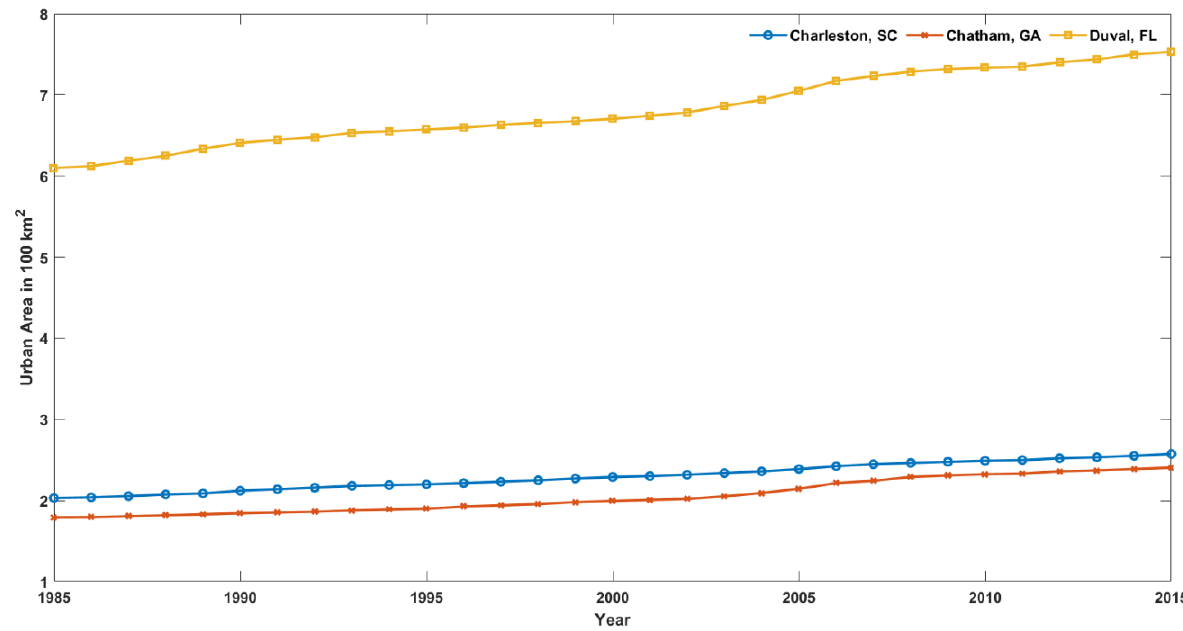
Figure 7. The annual distribution of urban area in the three counties.